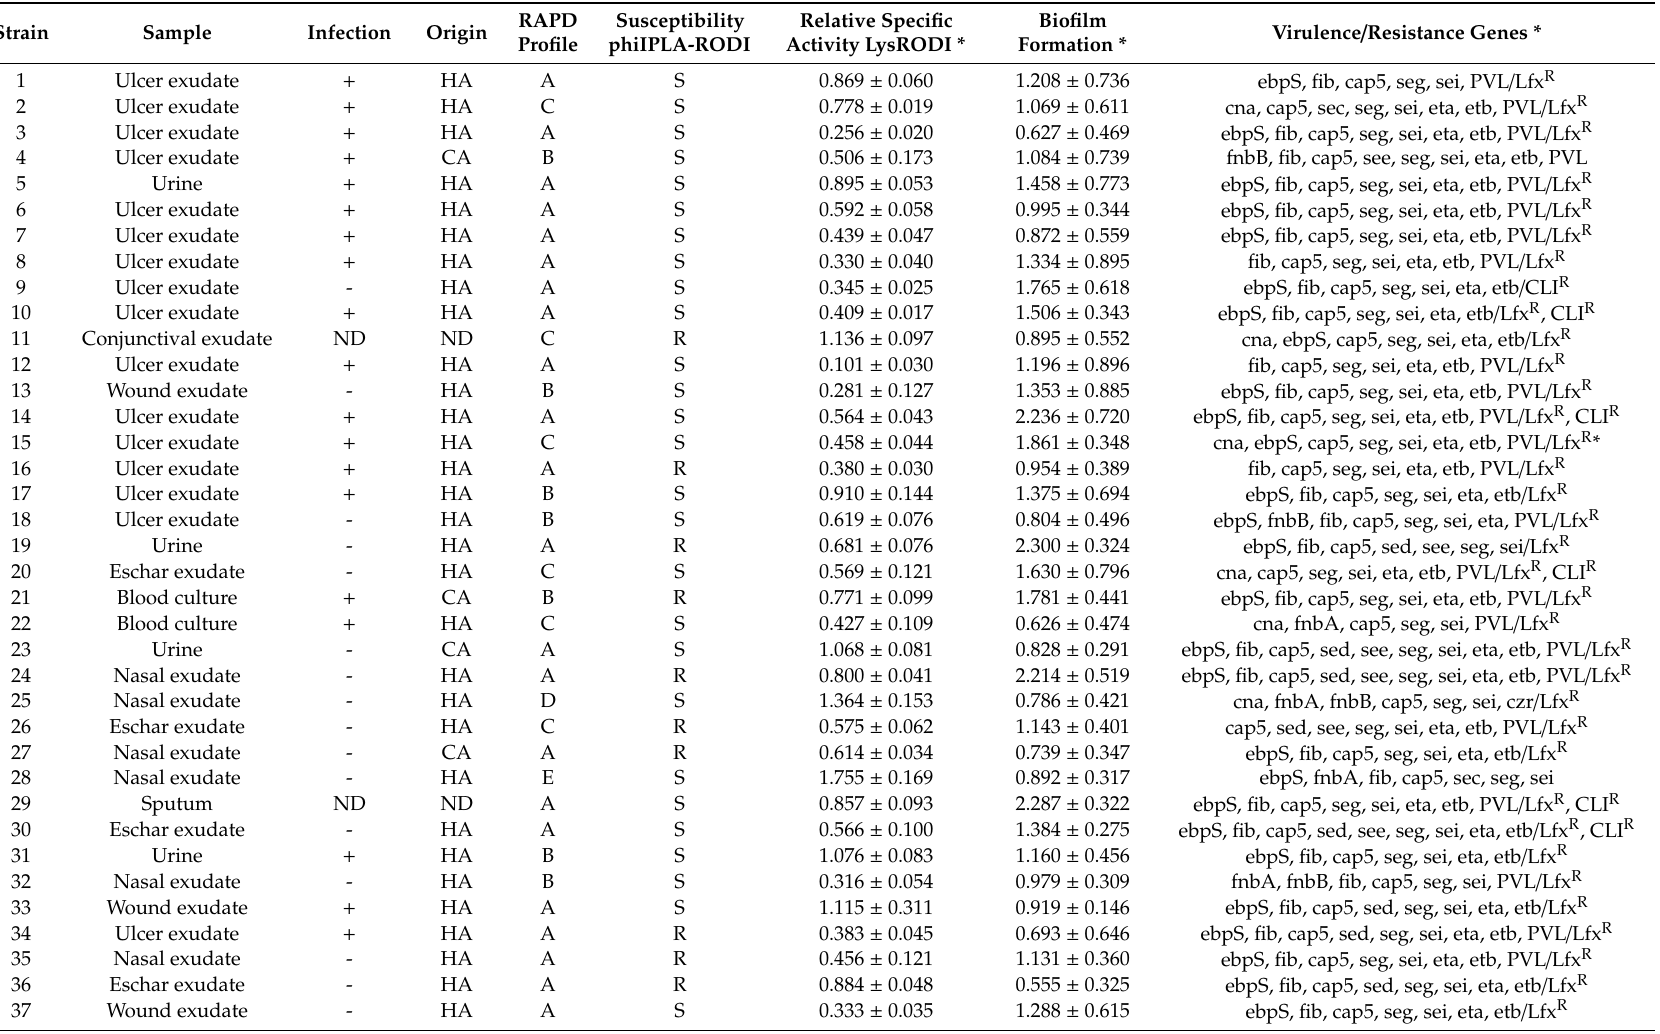
Table 1. Genotypic and phenotypic characteristics of clinical MRSA